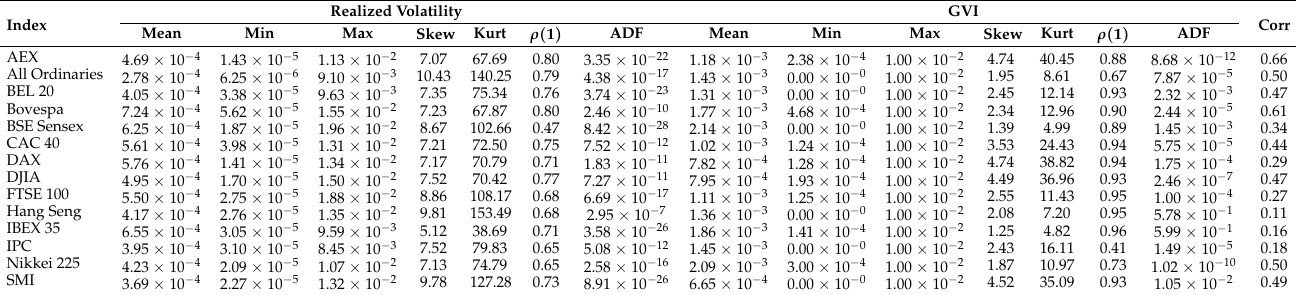
Table 2. Summary statistics for RV and